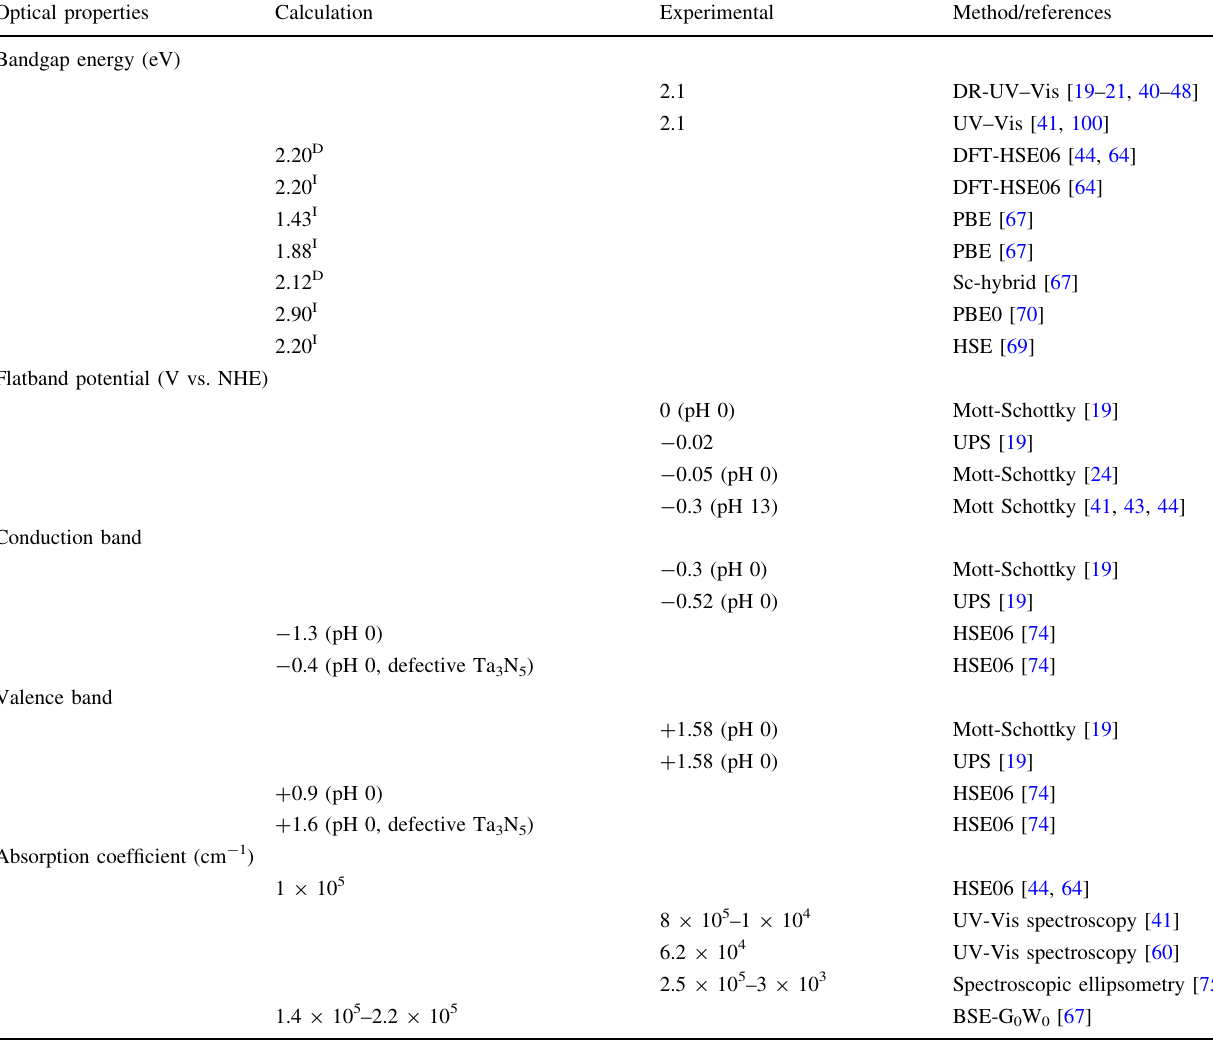
Table 2 Ta 3 N 5 optical properties and band positions Optical